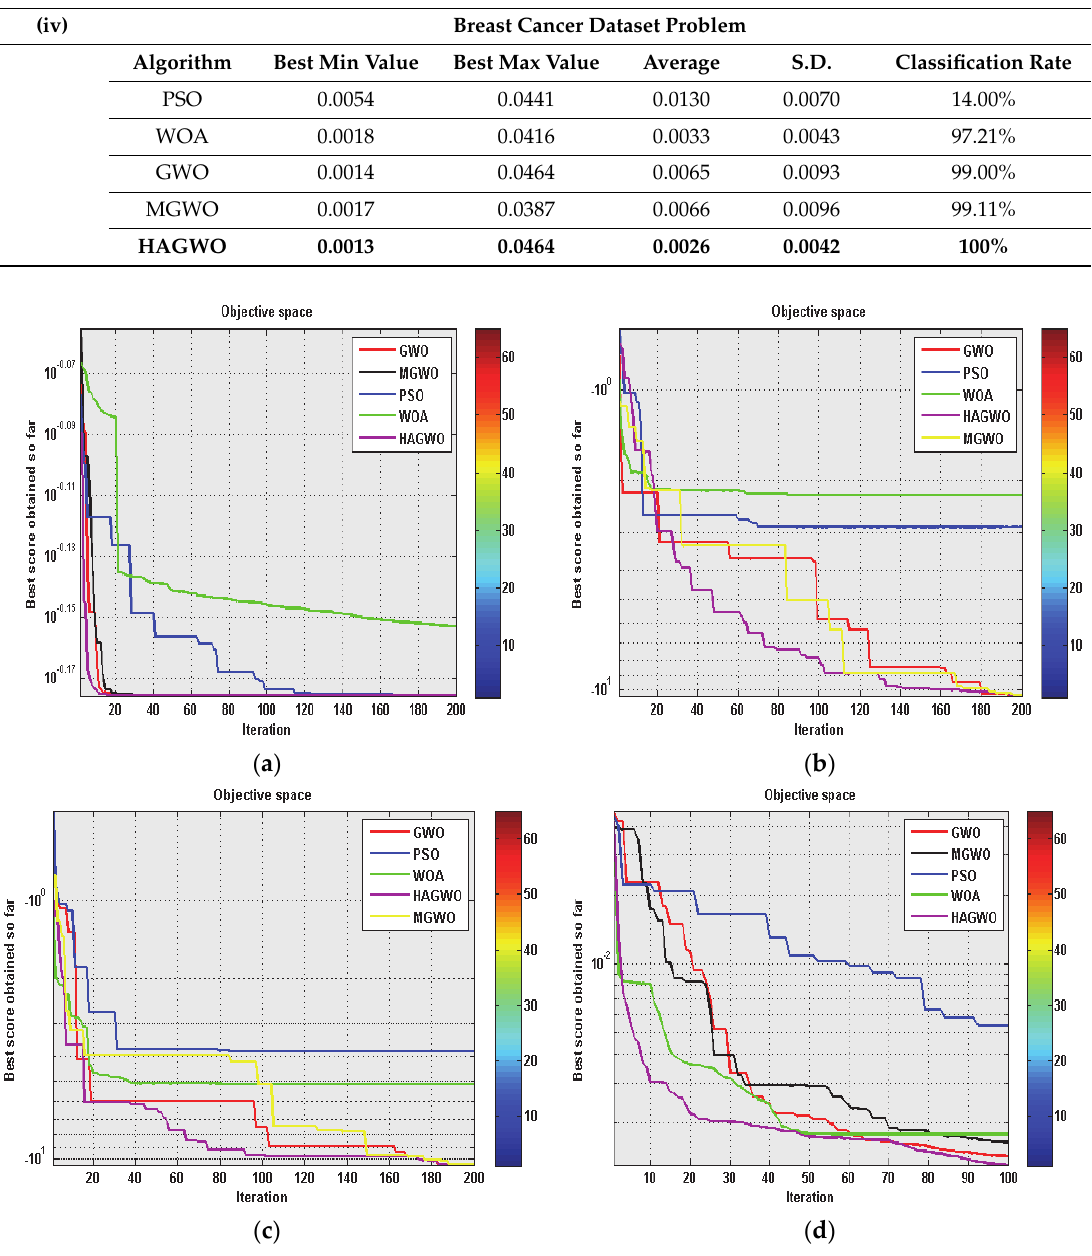
Figure 5. ( a ) Convergence graph of Iris dataset problem; ( b ) Convergence graph of XOR dataset problem; ( c ) Convergence graph of Baloon dataset problem; ( d ) Convergence graph of Breast cancer dataset problem.